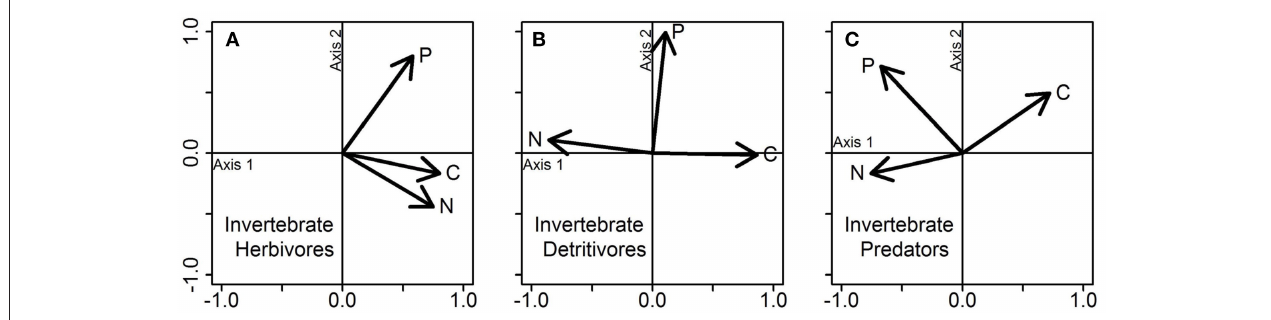
FIGURE 6 | PCA on the stoichiometric traits of (A) invertebrate herbivores, (B) invertebrate detritivores, and (C) invertebrate predators. Each plot represents a PCA conducted separately for each group of organisms, using the data displayed jointly in Figure 5 . Vectors show the influence of the three stoichiometric traits (C, N, and P contents) on each PCA axis.